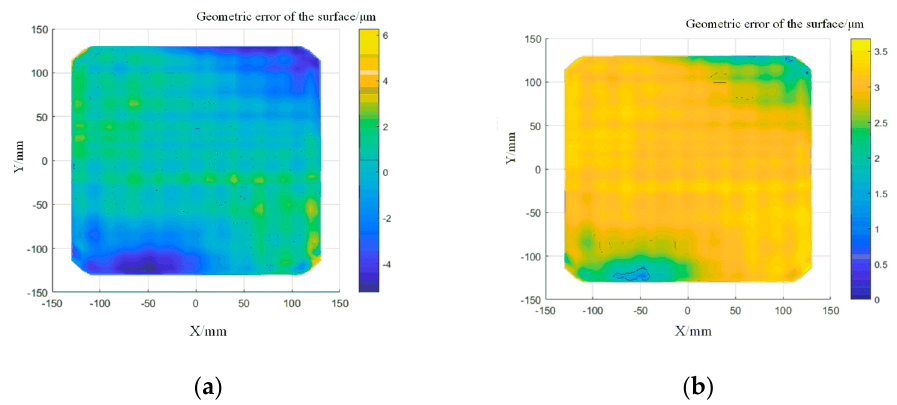
Figure 11. Profile error distribution after pseudo-random path polishing: ( a ) surface profile error distribution after ten times of polishing; ( b ) surface profile error distribution with pseudo-random path polishing.